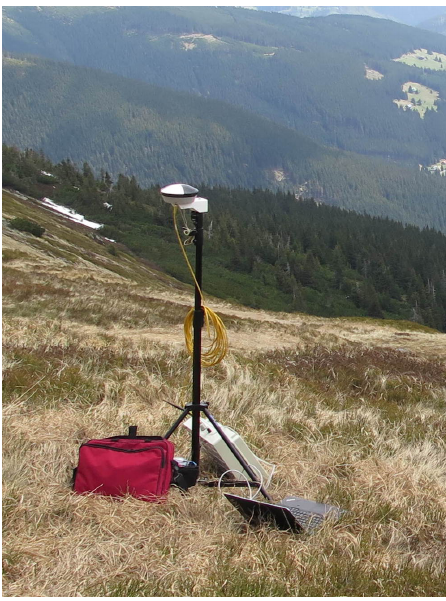
Figure 7. The base station (located close to the snow field) performing real-time GNSS corrections for the sensors aboard the